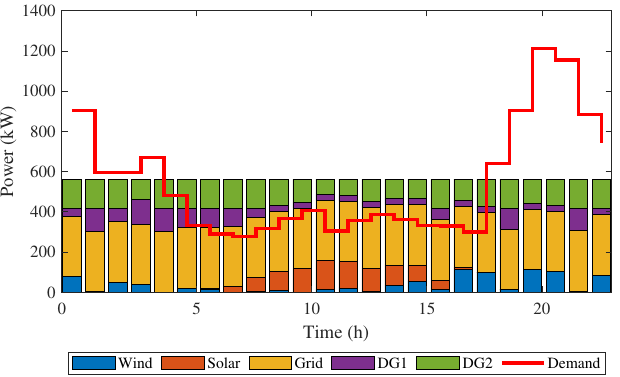
Figure 8. Case II: Microgrid generation scheduling for peak day with actual data.